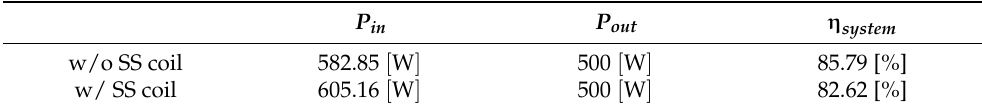
Table 5. Power transfer efficiency without and with SS coils.